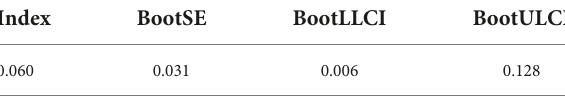
TABLE 7 Index of the conditional moderated mediation